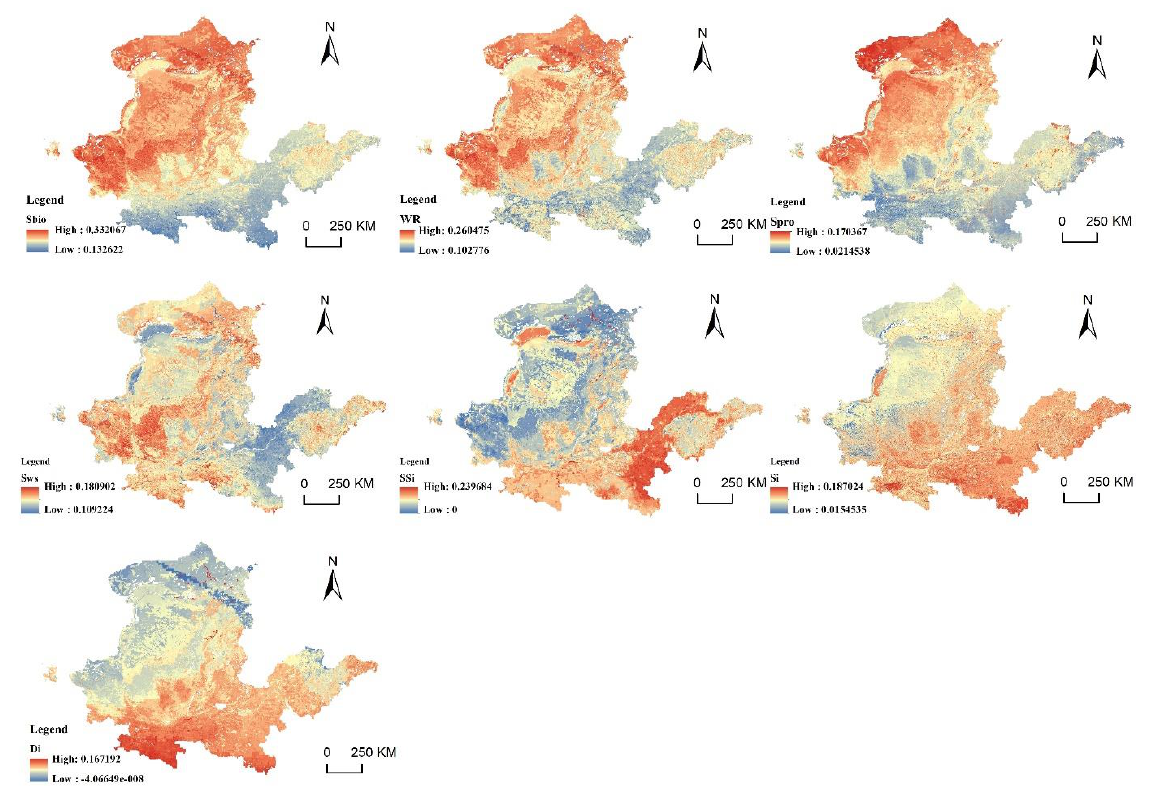
Figure 10. Ecological-importance barriers in 2010. In 2010, the average obstacle degrees of biodiversity, significance of water-source conservation, and significance of windbreaks and sand fixation were 26.28%, 20.83% and 14.29%, respectively. In 2015, the average obstacle degrees were 26.53%, 25.01% and 14.31%, respectively. The average obstacle degree in 2020 was 25.84%, 20.29% and 13.94%, respectively, showing a rough trend of decreasing obstacle degree. The obstacle degree of land-desertification sensitivity was 7.82% in 2010, 8.01% in 2015 and 8.2% in 2020, showing